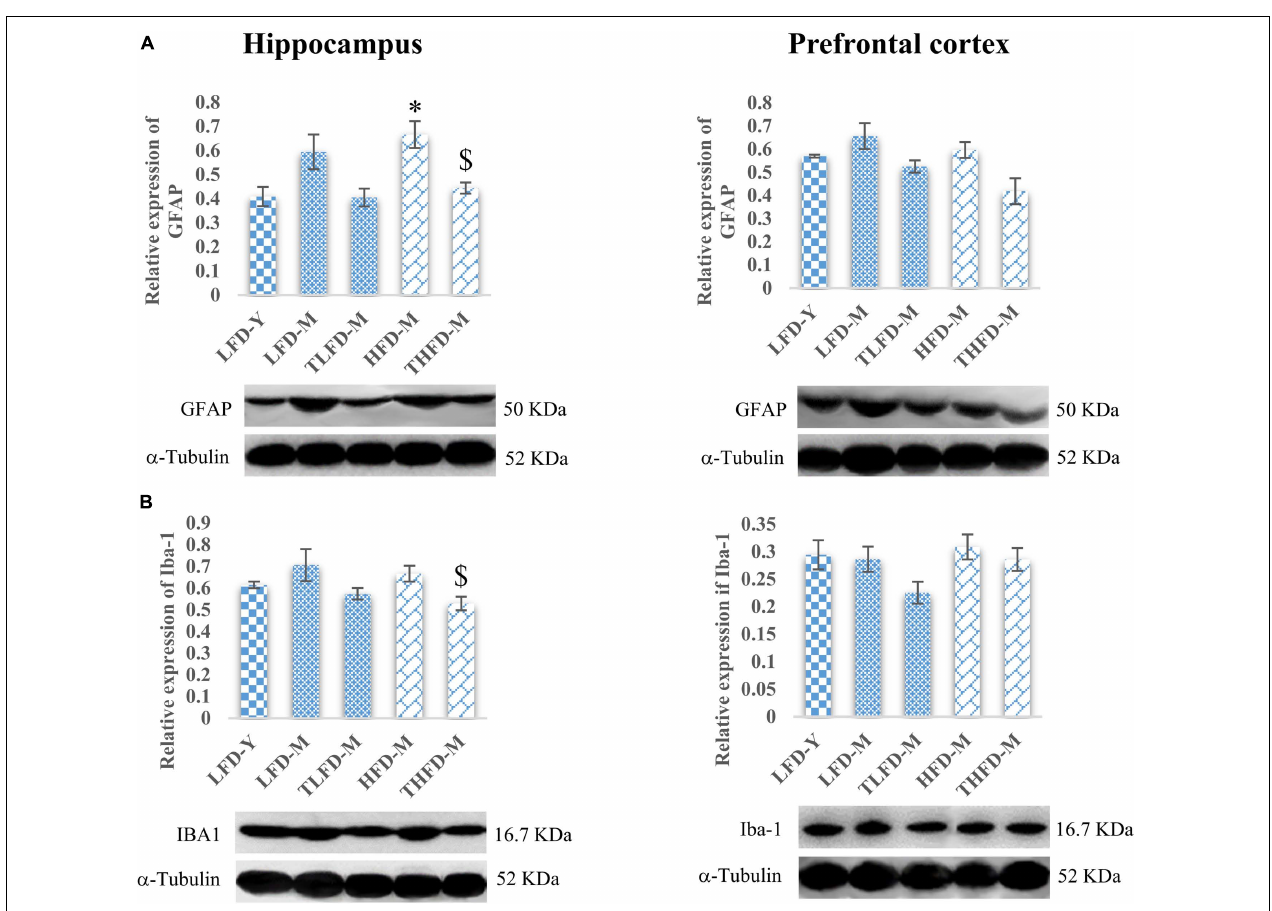
FIGURE 3 | Tinospora cordifolia stem powder (TCP) supplementation ameliorated reactive gliosis and microgliosis in middle-aged acyclic female rats. Histogram representing analysis of fold change in expression of (A) GFAP and (B) IBA1 in the hippocampus (left panel) and the prefrontal cortex (PFC) (right panel) regions of the brain. Values are presented as mean ± SEM. ∗ p ≤ 0.05 LFD-Y vs. HFD-M; $ p ≤ 0.05 HFD-M vs.